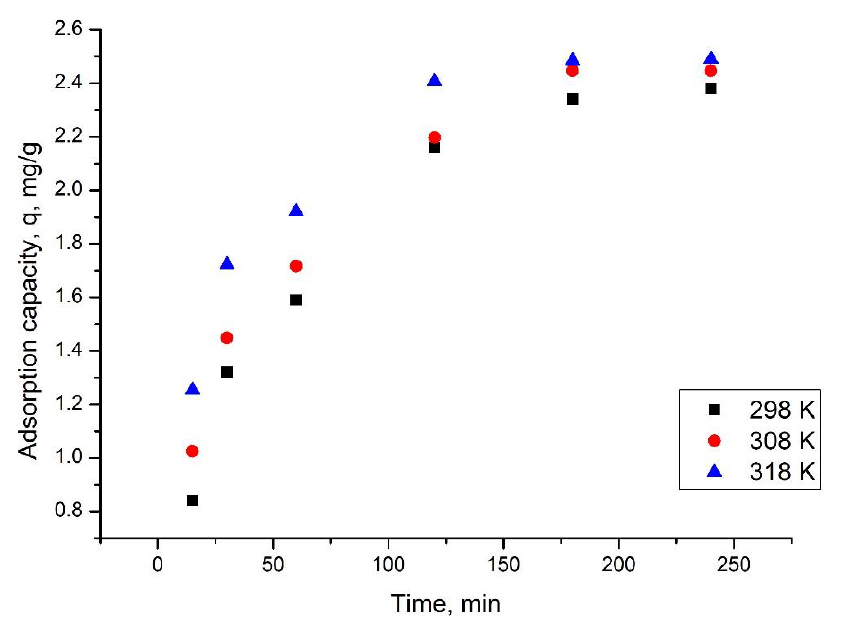
Figure 6. Contact time and temperature influence (0.1 g of adsorbent, 25 mL solution containing 10 mg L −1 Ru(III), pH 2).